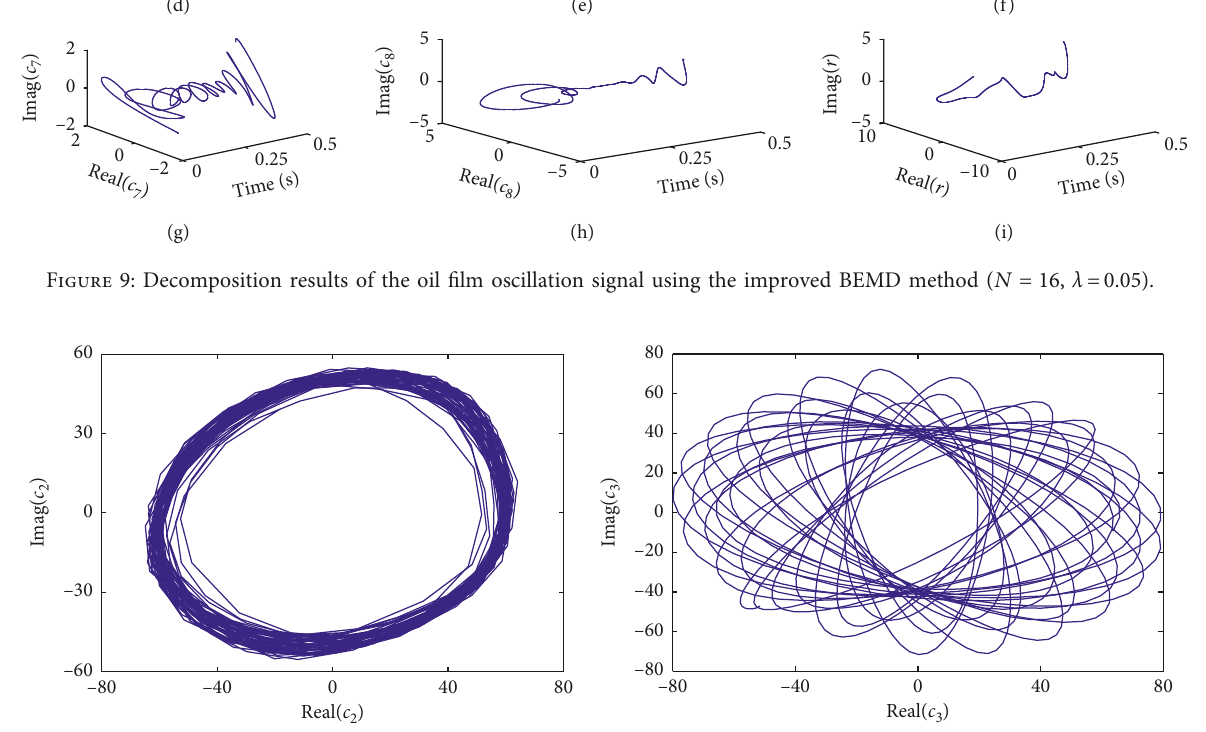
Figure 10: The orbits were made up of c 2 (a) and c 3 (b) obtained with the improved BEMD